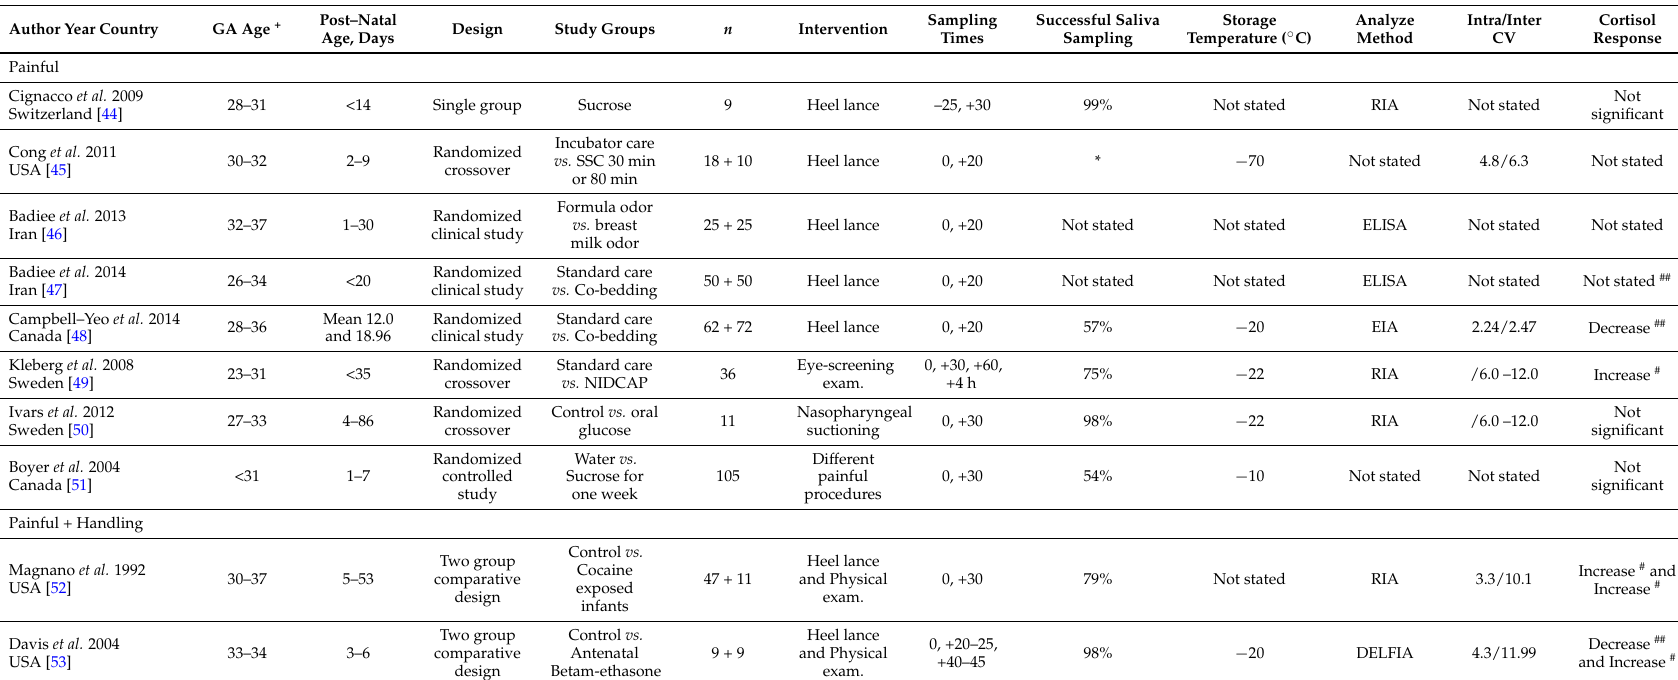
Table 1. Descriptive data of included studies (n =